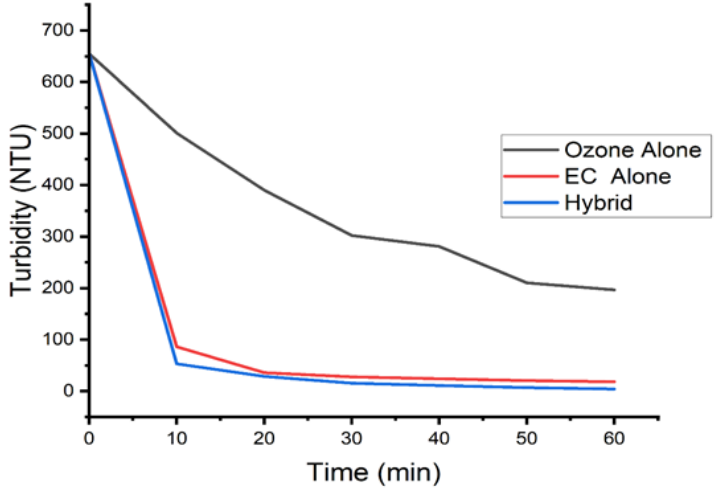
Figure 3. Turbidity reduction for separate processes such as pure ozone, electrocoagulation and coupled process of EC/O 3 , operated at conditions of 10.0 volts, feed flow 360 L/h, O 3 flow 2400 mg/h, pH 6.89, and initial turbidity of 655